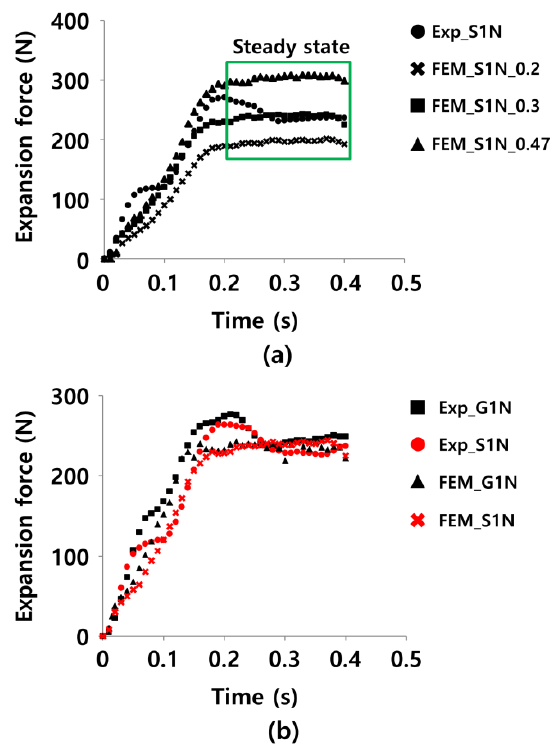
Figure 3. ( a ) Effects of friction coefficients (0.2, 0.3, 0.47) on expansion forces for the S1N group; and ( b ) comparisons of expansion forces between the expansion experiments and FE analyses for the S1N and G1N groups.